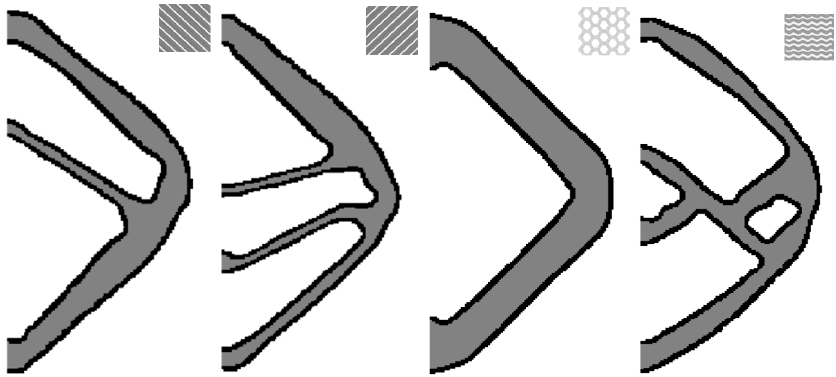
Figure 20. The optimized results with di ff erent infill